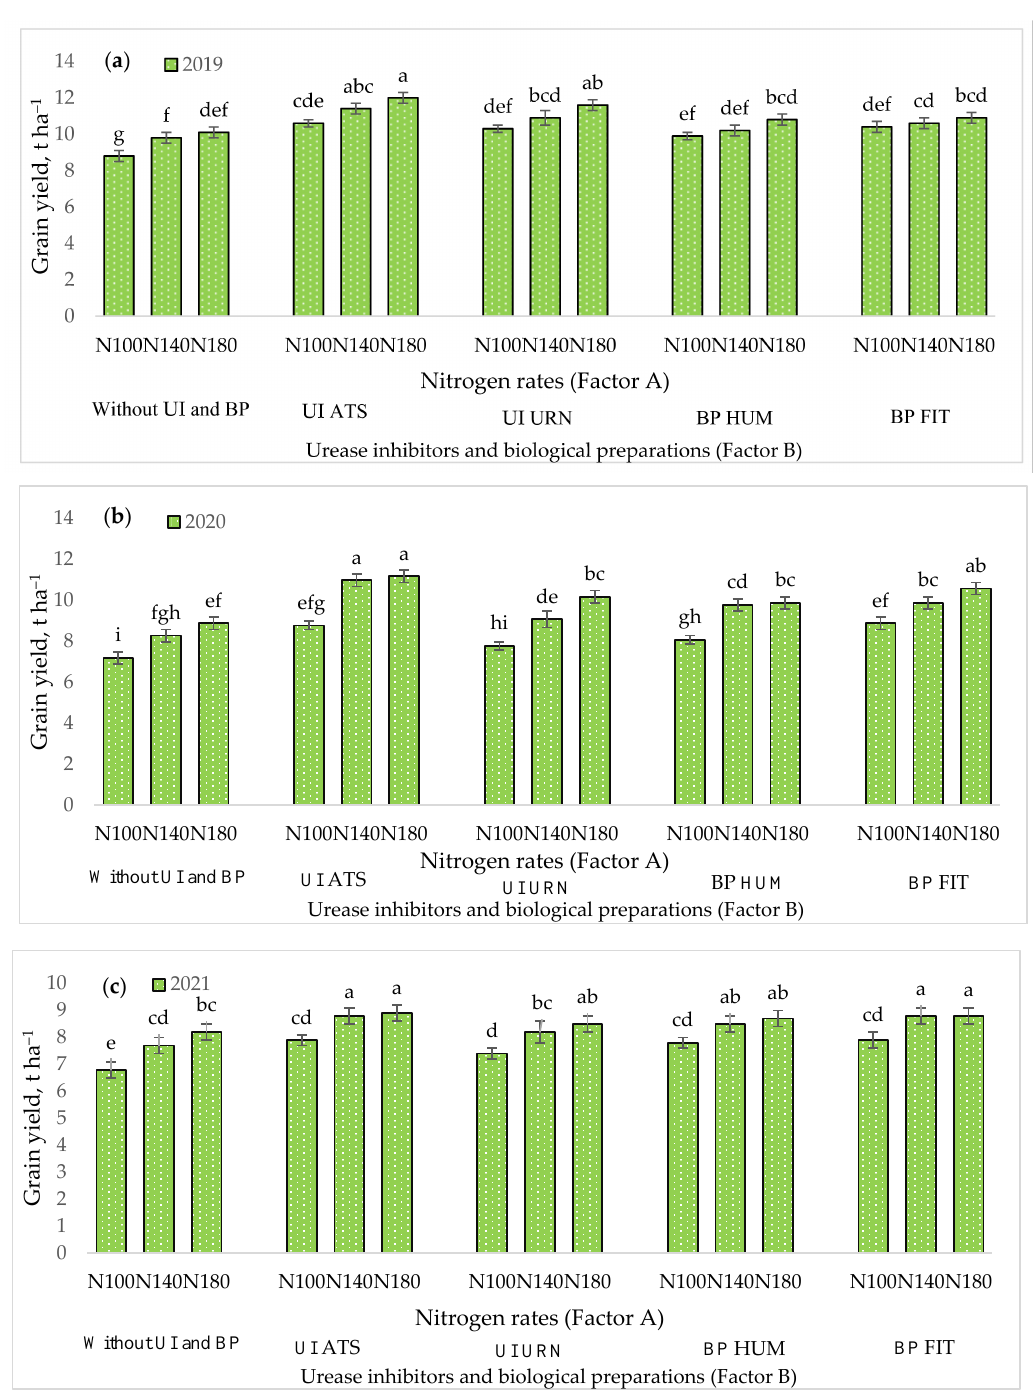
Figure 2. The influence of different nitrogen fertilizer rates, urease inhibitors, and biological prepa- rations on maize grain yield, 2019 ( a ); 2020 ( b ); 2021 ( c ). UI—urease inhibitor; ATS—ammonium thiosulfate; URN—N-butyl-thiophosphoric triamide (NBPT) and N-propyl-thiophosphoric tri- amide (NPPT); BP—biological preparation; HUM—suspension of humic and fulvic acids; FIT—sus- pension of Ascophyllum nodosum . The differences between the means of the treatments with the dif- ferent letters are significant ( p < 0.05). Vertical dashes indicate the mean error.